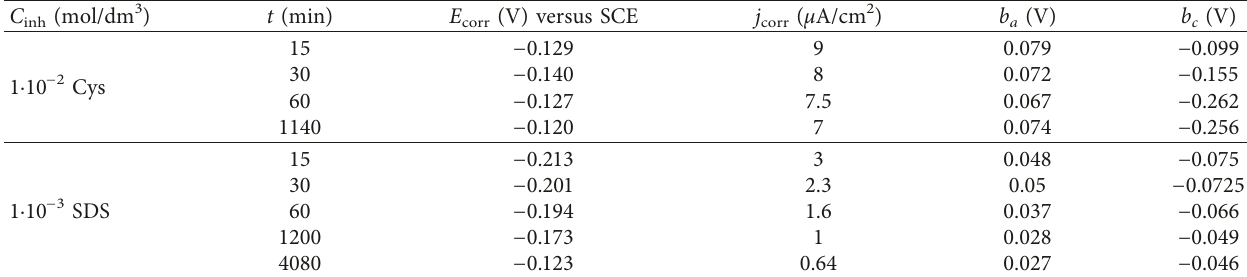
Table 3: Corrosion parameters for brass in acidic chloride solution after immersion in cysteine and SDS solutions for various periods of time. C inh (mol/dm 3 )